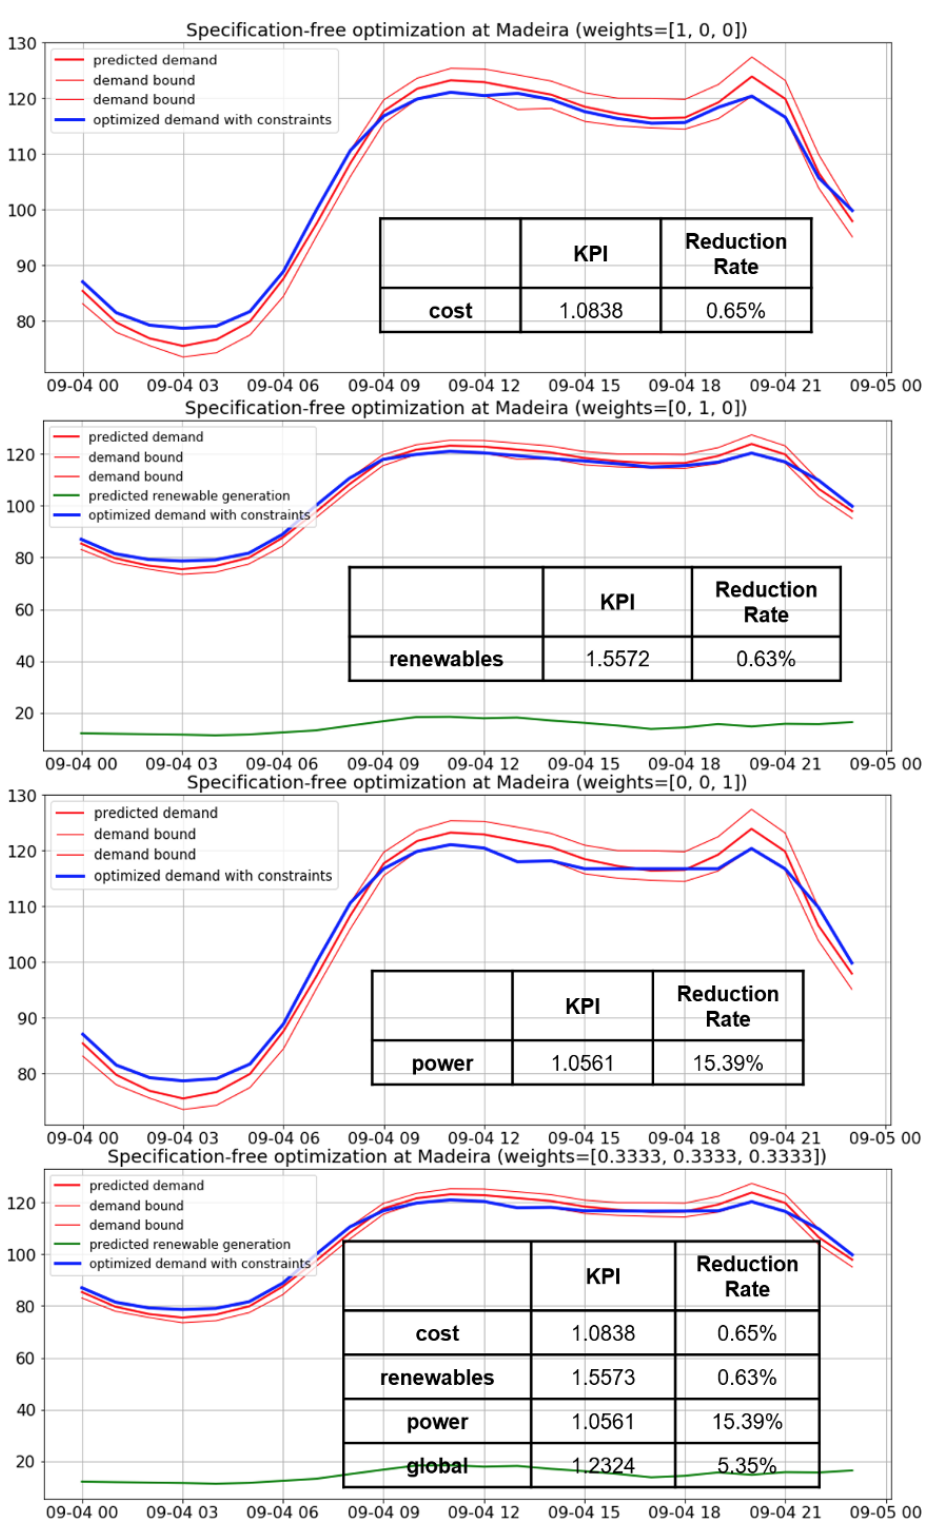
Figure 12. Examples of the application of the optimization approach to Madeira. In the titles, the weights for cost, renewables and power KPIs respectively are shown. In the vertical axis, the measurement unit is